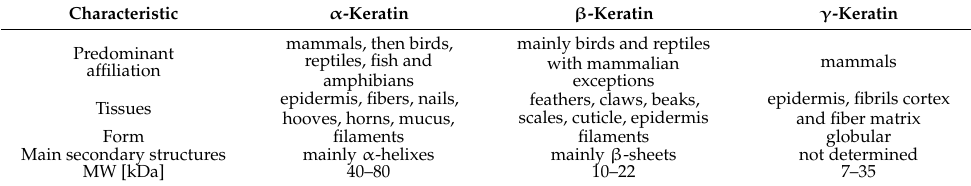
Table 1. Keratin types characteristics